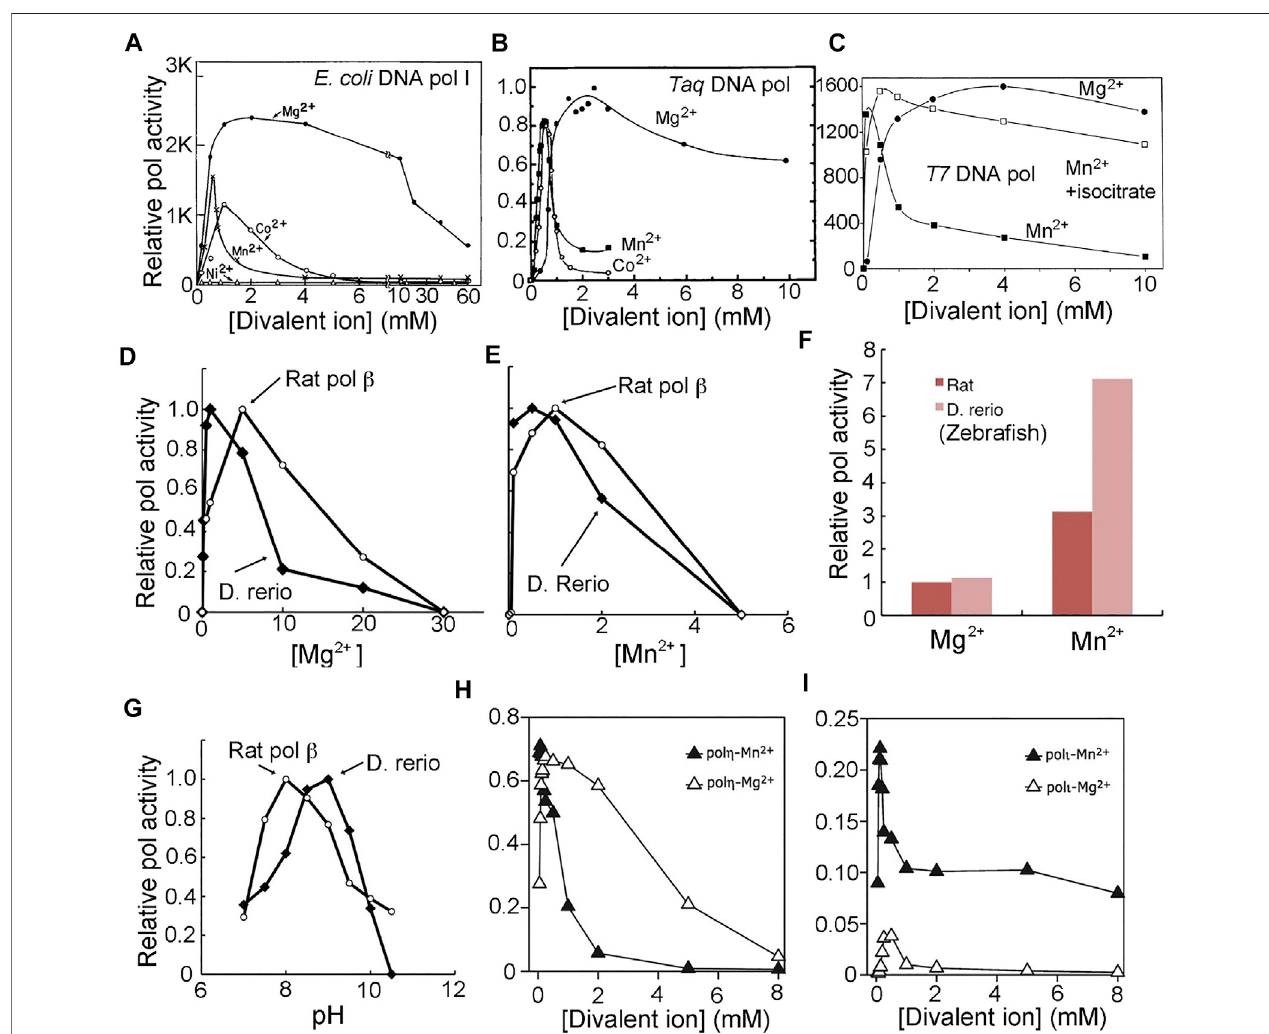
FIGURE 4 | Bell-shaped polymerase activity pro fi les as a function of divalent metal ions and pH. With the exception of (A) and (C) , which show nucleotide incorporation under given experimental conditions on the pol product scale, all others are shown on a relative scale. With the exception of (G) , which is a pH-activity pro fi le, all others are metal ion-activity pro fi les. (A) E. coli DNA polymerase I (adapted from Sirover et al., 1979, J. Biol. Chem.). (B) Taq DNA polymerase (adapted from Lawyer et al., 1993, PCR MethodsAppl.). (C) T7 DNA polymerase (adapted from Tabor and Richardson, 1989, with permission, ©National Academy of Sciences, 1989). (D – G) D. rerio (zebra fi sh) pol β and rat pol β (adapted from Ishido et al., 2011, Microbial Cell Factories). (F) scale factor between two metal ions and two species. (H, I) Human pol η and pol ι (adapted from Frank and Woodgate, 2007, J. Biol.